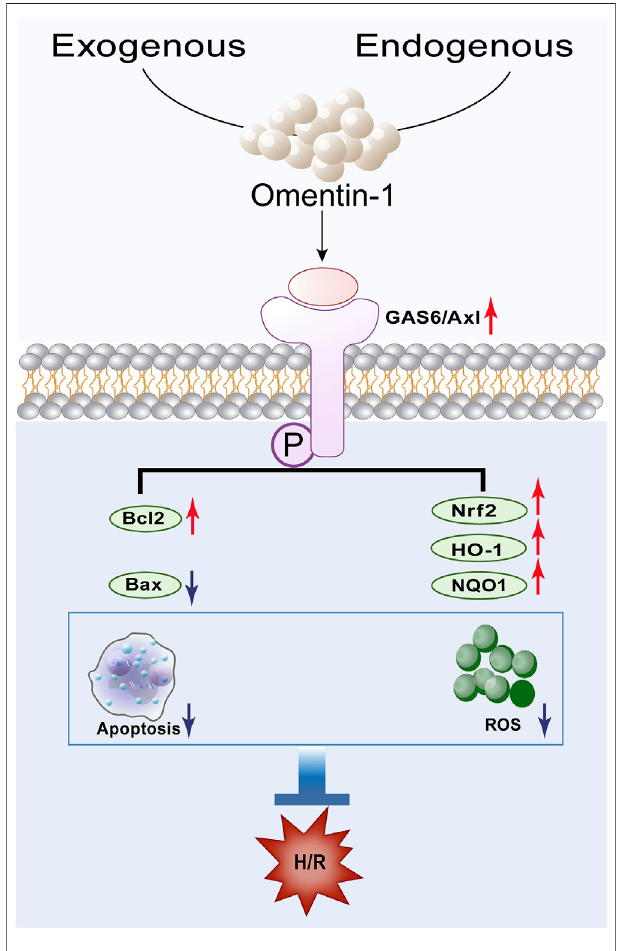
FIGURE 10 | Schematic depicting the proposed mechanisms by which omentin-1 protects against H/R-induced injury by activating the GAS6/Axl signaling